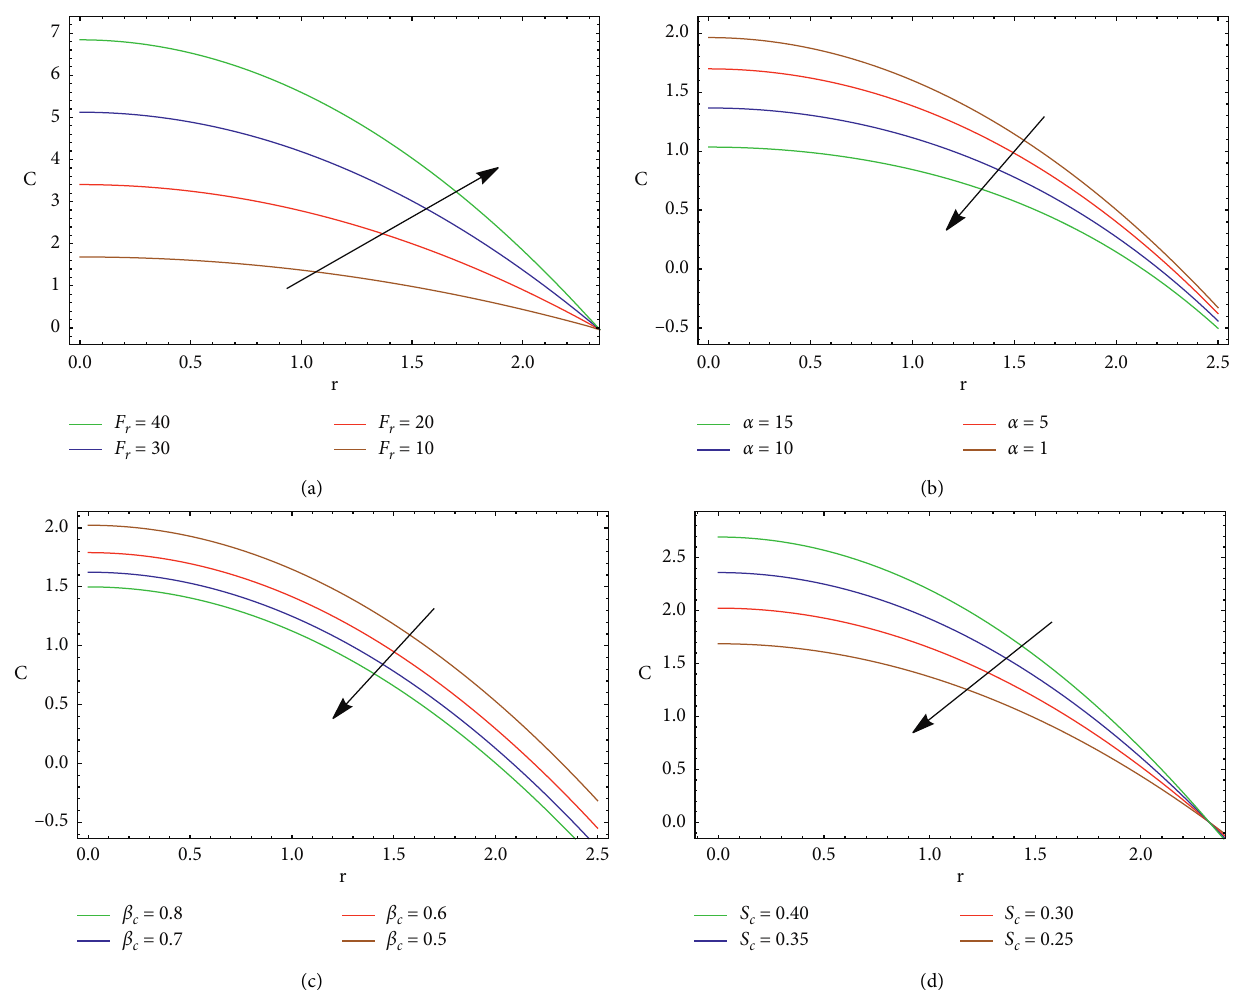
Figure 5: The variation of the concentration C ( r ) for different values of F